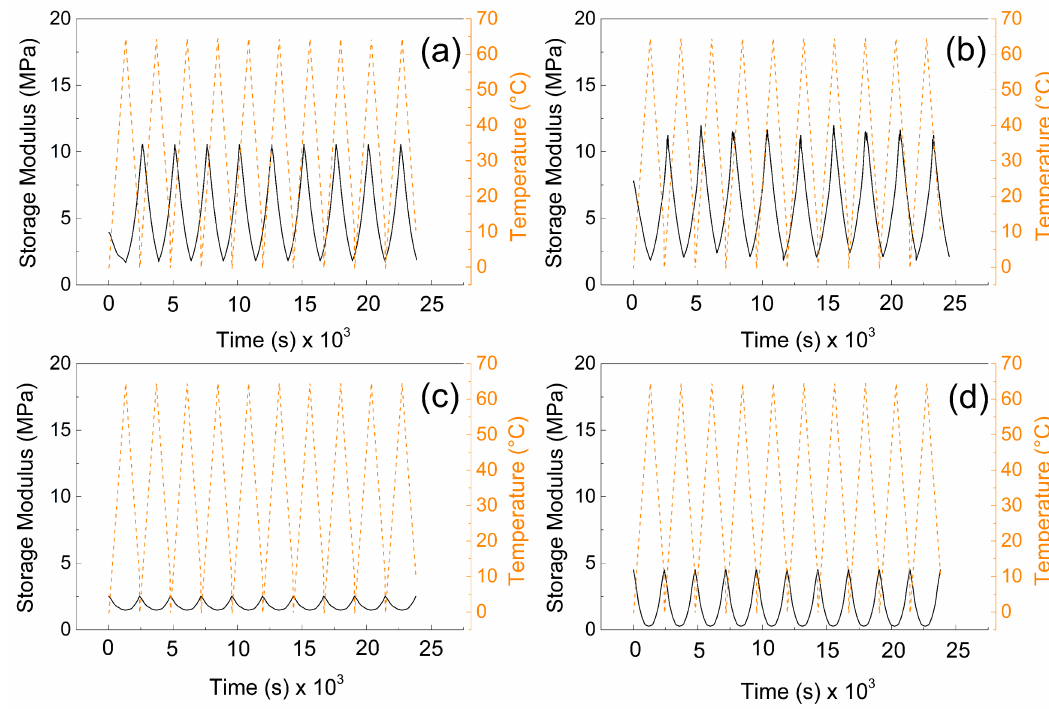
Figure 6. DMA investigation of the ( a ) P1, ( b ) P05, ( c ) PW1, and ( d ) PW05.